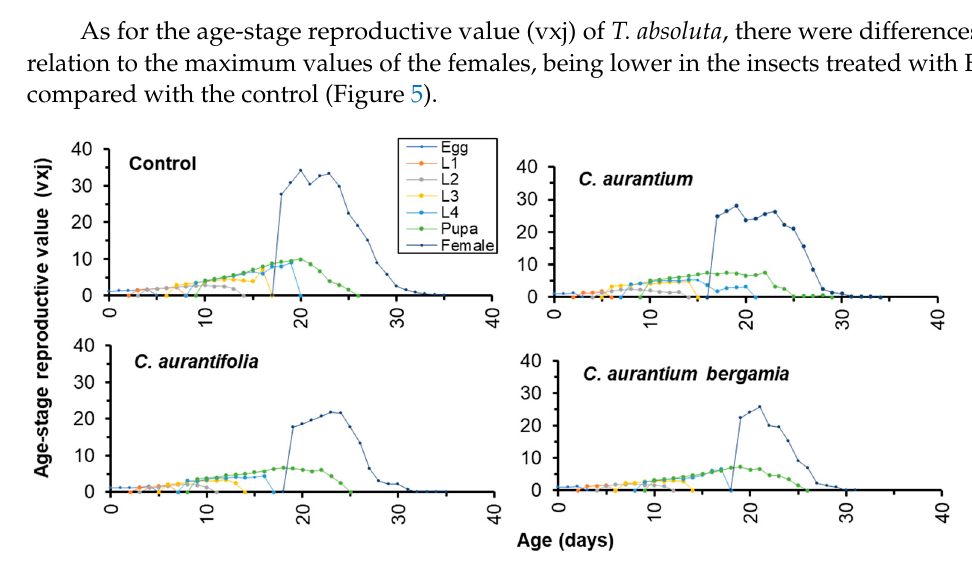
Table 3. Reproductive parameters of Tuta absoluta exposed to LC 50 Citrus aurantifolia, Citrus au- rantium and Citrus aurantium bergamia EOs and only acetone (control).